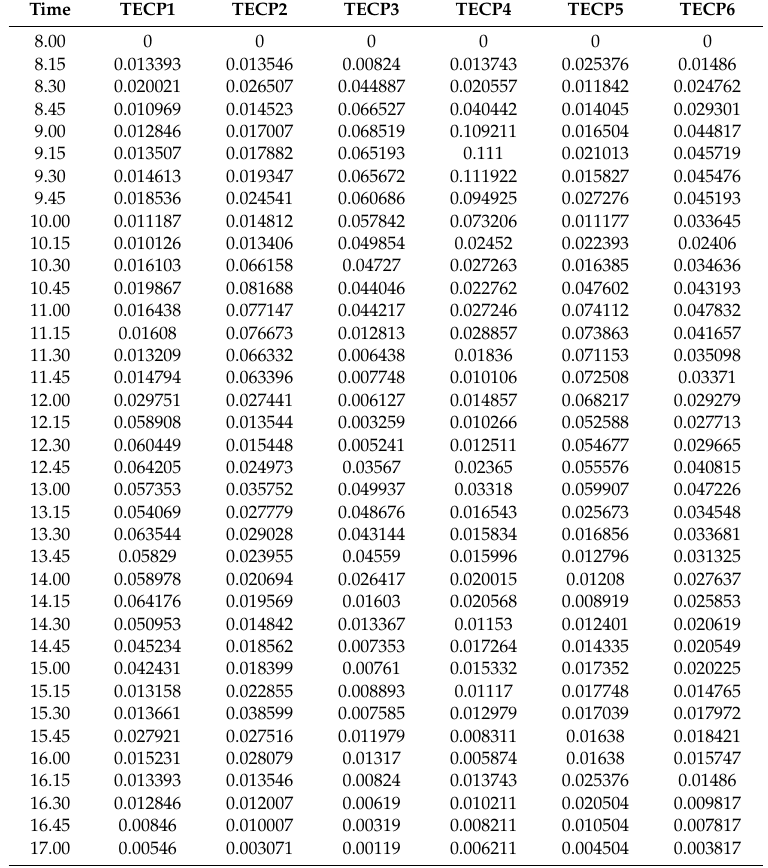
Table A2. The typical energy consumption profiles, with a sampling size by quarter-hour, (kW / kWh).